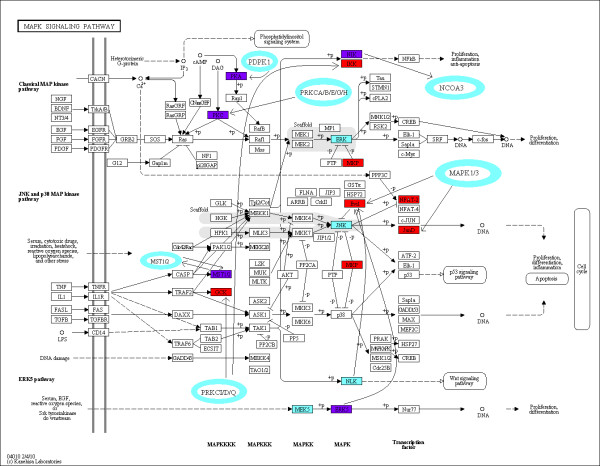
KEGG MAPK Pathway revised by adding predicted phosphorylation events. Brackets lined with red identify those nodes in the existing KEGG diagram occupied by a kinase substrate whereas the blue lined brackets identify those occupied by kinases. The proteins that act both as kinases and substrates are shown in purple. The oval shaped nodes are our predictions of kinases that also phosphorylate existing nodes in the KEGG diagram.